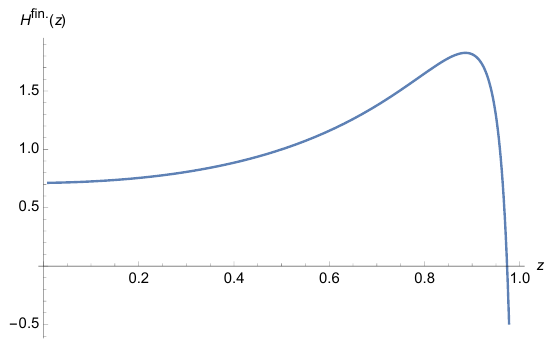
Figure 4 . Figure showing the dependence of H fin. ( z ) on z